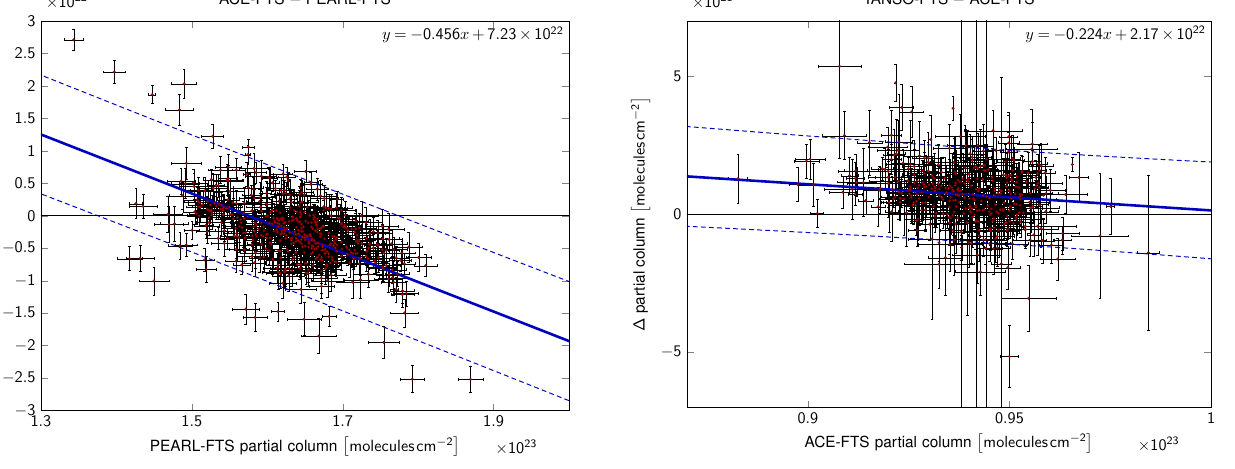
Figure 16. Partial column differences ACE-FTS – PEARL-FTS as a function of PEARL-FTS partial column. Based on a shared sensi- tivity calculations, partial columns are estimated in a range of 5.3– 29.9km. The solid blue line shows the results of a linear model with the parameters for offset and slope obtained with a weighted least squares fit. The dashed blue lines show a 95% confidence interval around this estimate. The equation in the upper right describes the linear model fit. See Table 2 for uncertainty estimates on slope and offset.